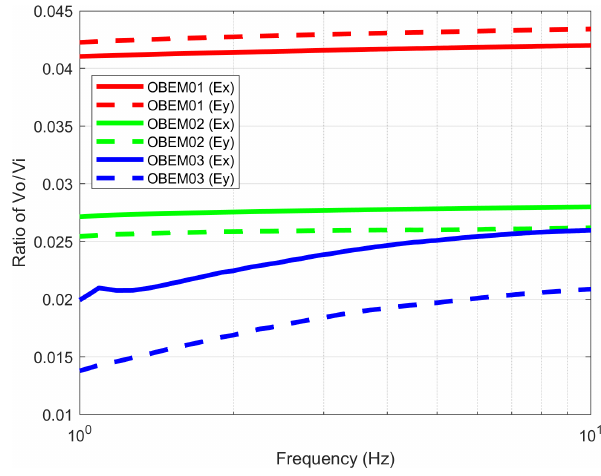
Figure 8. The responses of the electrodes with varying frequencies. The response curves of V o /V i are proportional to the frequency on a log